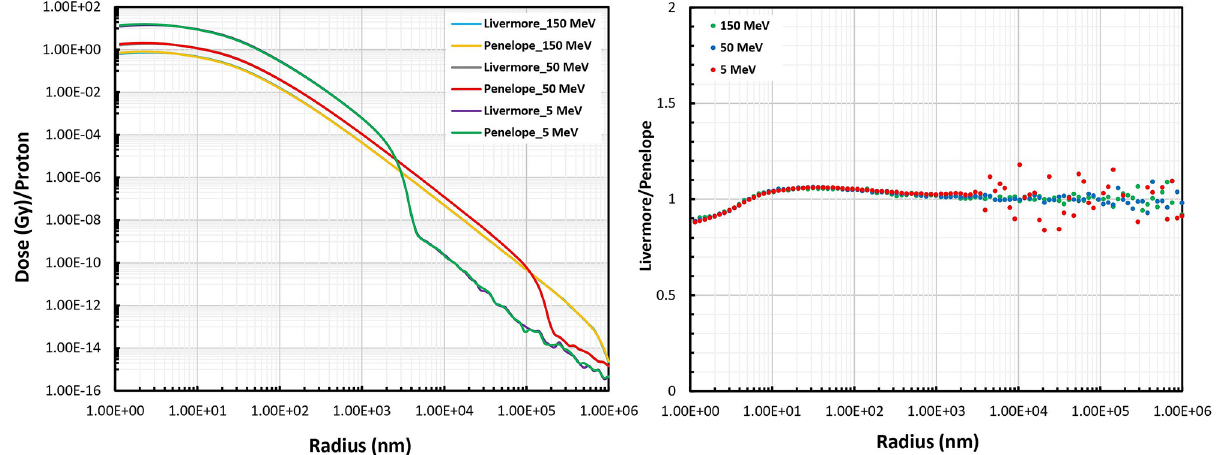
Figure 5. Comparison of the RDD between the Livermore and Penelope models obtained for 5, 50, and 150- MeV proton beams as a function of radial distance from the GNP surface.